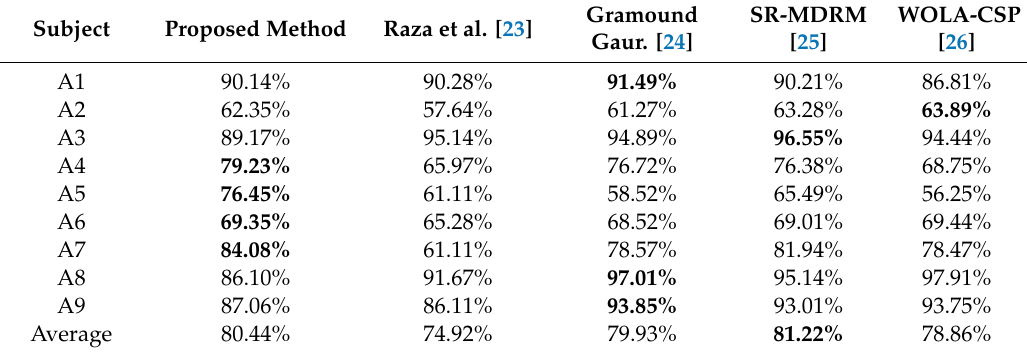
Table 1. Comparison of classification accuracy (in %) for the completion of the LvR task of the proposed method with published results of the dataset 2a obtained from the BCI competition IV that included left- and right-hand movement data.